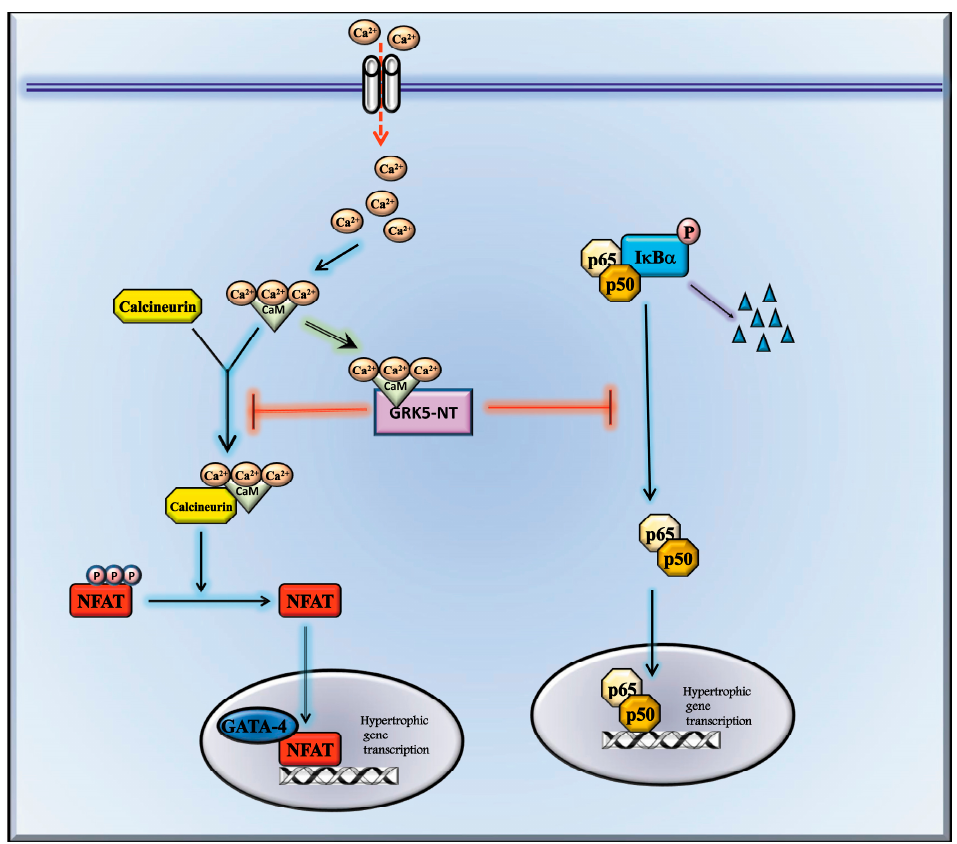
Figure 5. Schematic representation of the molecular mechanism. GRK5-NT regulates GATA-4 and NFAT activation by competing with calcineurin for binding to calcium-calmodulin. PE induces an increase of intracellular calcium levels. Calcium binds calmodulin and activates calcium-calmodulin dependent factors such as calcineurin. Calcineurin, in turn, dephosphorylates NFAT leading to NFAT nuclear translocation and activation of gene transcription. GRK5-NT binds calcium-calmodulin, through the calmodulin binding site (CBS), thus inhibiting its binding to calcineurin. Inactivated calcineurin is not anymore able to dephosphorylate NFAT and this causes the inhibition of NFAT dependent gene transcription and the inhibition of NFAT dependent GATA-4 activation. Besides this effect of GRK5-NT, the peptide is also able to inhibit I κ B degradation, thus preventing NF κ B transcription activity.